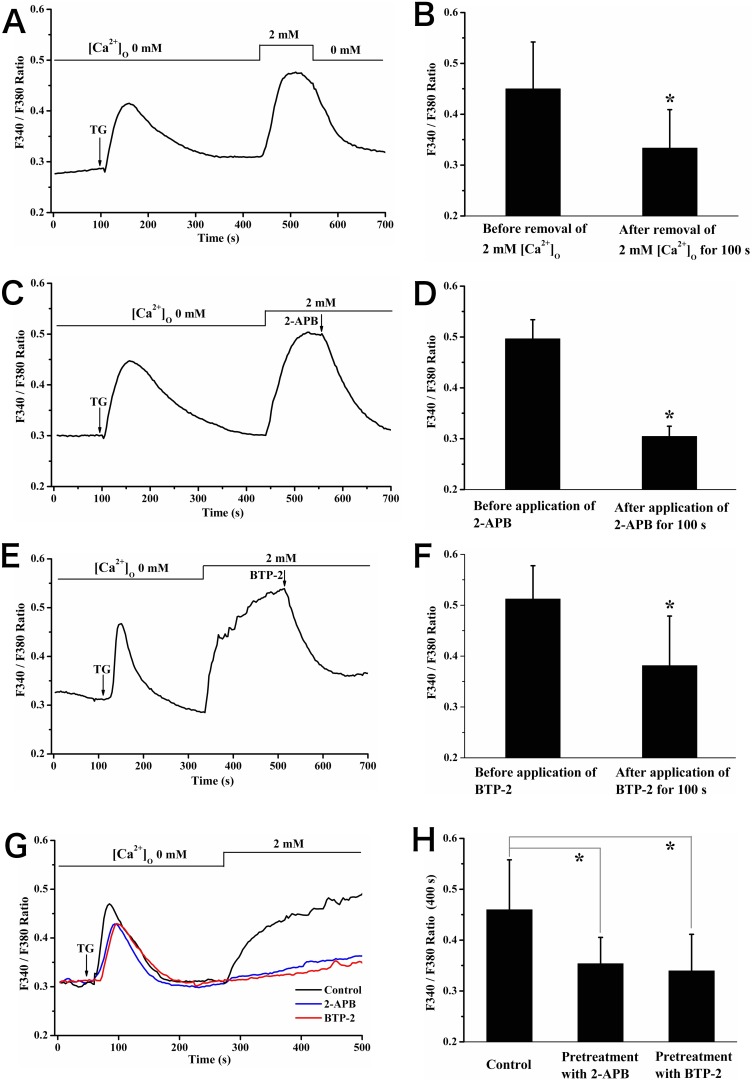
TG induced SOCE in rat calvarial osteoblasts.(A) After calcium store depletion by a calcium pump blocker TG (1 µM) in Ca2+-free buffer, addition of 2 mM external Ca2+ resulted in obvious calcium entry; then, further removal of external Ca2+ caused [Ca2+]c decrease to baseline, suggesting the putative response for SOCE. (C, E) [Ca2+]c increase was caused by TG (1 µM) in Ca2+-free HBSS, followed by application of 25 µM 2-APB or 20 µM BTP-2 during the high [Ca2+]c plateau induced by re-addition of 2 mM external Ca2+, resulting in return to baseline [Ca2+]c. Statistic data of ratio of F340/F380 before and after the application of Ca2+ free HBSS (B), 2-APB (D) and BTP-2 (F). * showed P<0.05. (G) 1 µM TG was added after pretreatment with 25 µM 2-APB or 20 µM BTP-2 for 15 min, then, further addition of 2 mM external Ca2+ had no effect on [Ca2+]c change. (H) Summary of the ratio of F340/F380 at 400 s from experiments shown in (G), * showed P<0.05.